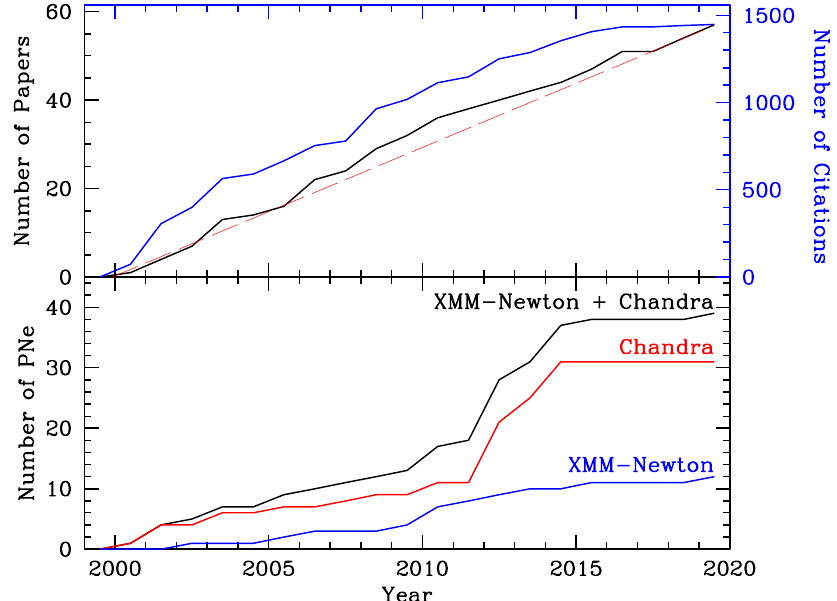
Figure 1. (bottom) Time evolution of the number of PNe detected by the Chandra (red) and XMM-Newton (blue) X-ray observatories. (top) Time evolution of the number of papers (black) and citations to these papers (blue) based on those X-ray observations (source Astronomycal Database System, ADS, at https://ui.adsabs.harvard.edu). Note that the left and right axes in this panel refer to numbers of papers and citations, respectively, as denoted by their labels and colors. The red-dashed line is a linear fit to the number of papers, implying a publication rate (cid:39) 3 papers per year on the X-ray emission from